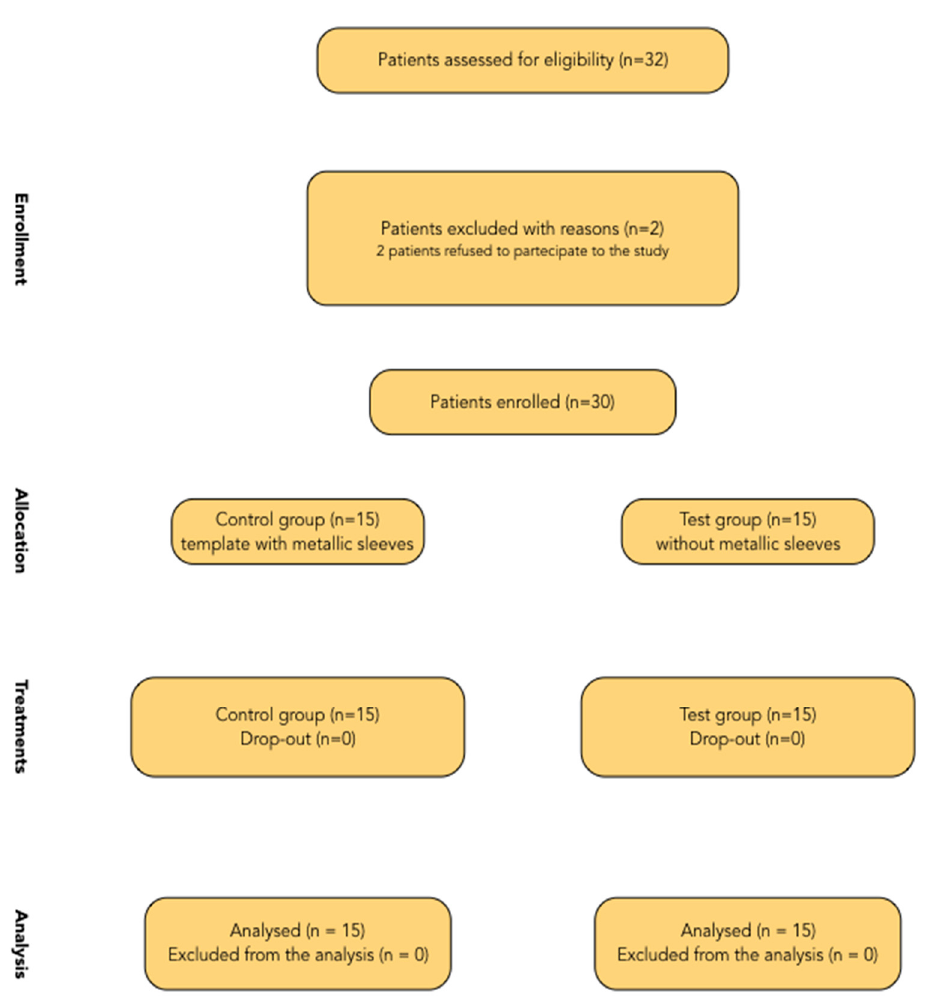
Figure 6. Consolidated Standards of Reporting Trials (CONSORT) diagram.